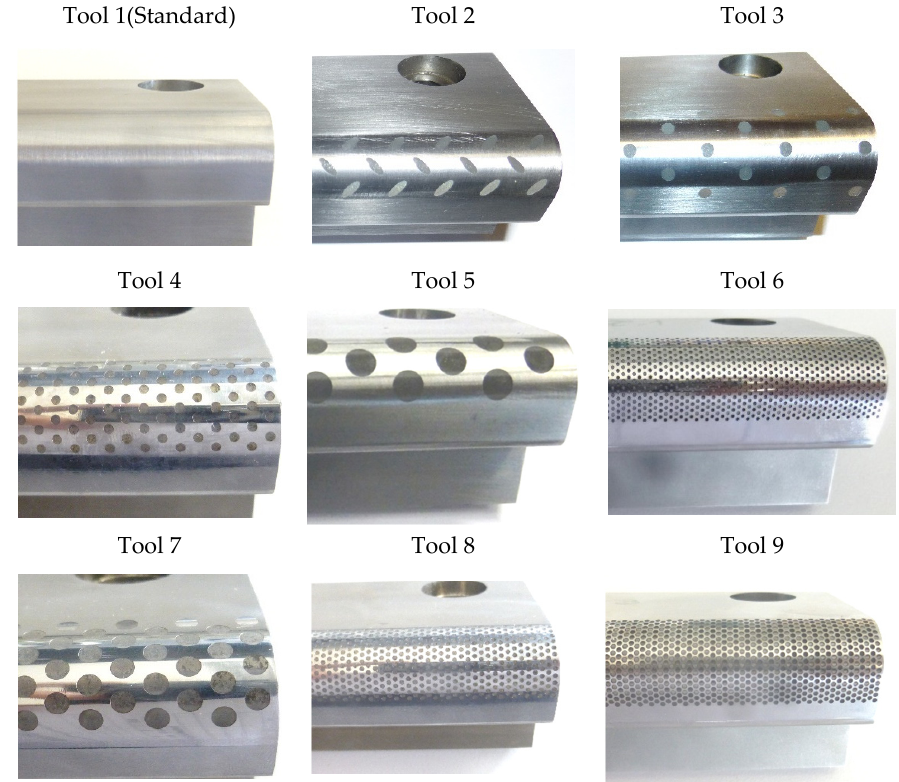
Figure 2. Manufactured tools with different surface structures (flat, elliptical, and circular) development for friction tests.